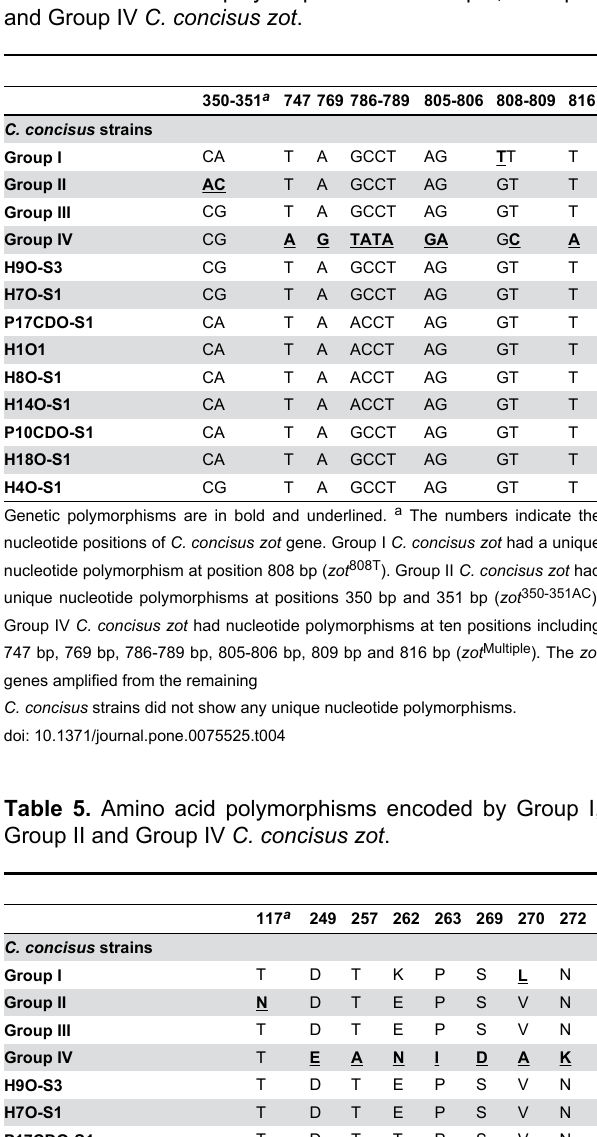
Amino acid polymorphisms are in bold and underlined. a The numbers indicate the amino acid positions of C. concisus Zot protein. zot 808T resulted in the change of valine to leucine at position 270. zot 350-351AC resulted in the change of threonine to asparagine at position 117. zot Multiple allele resulted in unique amino acids at seven positions.